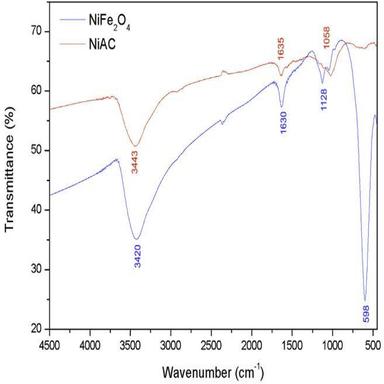
FTeIR spectra of NiFe2O4 (blue line) and NiAC (red line). (For interpretation of the references to color in this figure legend, the reader is referred to the Web version of this article.)